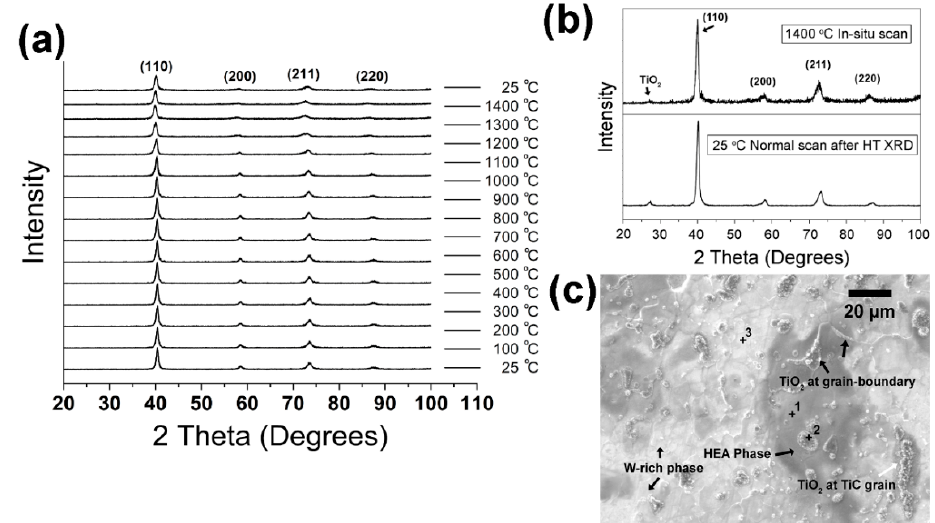
Figure 3. In-situ high temperature XRD analysis from room temperature to 1400 ◦ C showing ( a ) XRD plot at di ff erent temperatures, ( b ) XRD pattern collected at 25 ◦ C after in-situ XRD measurements at 1400 ◦ C and in-situ XRD pattern collected at 1400 ◦ C and ( c ) SEM micrograph of surface taken from the specimen after heating to 1400 ◦ C for in-situ XRD measurements.